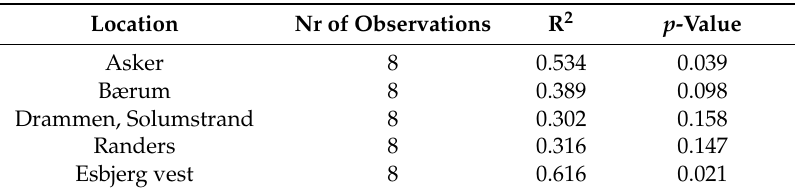
Table 12. Results from a linear regression analysis between rainfall and discharge for Asker, Bærum, Drammen, Randers, and Esbjerg vest.